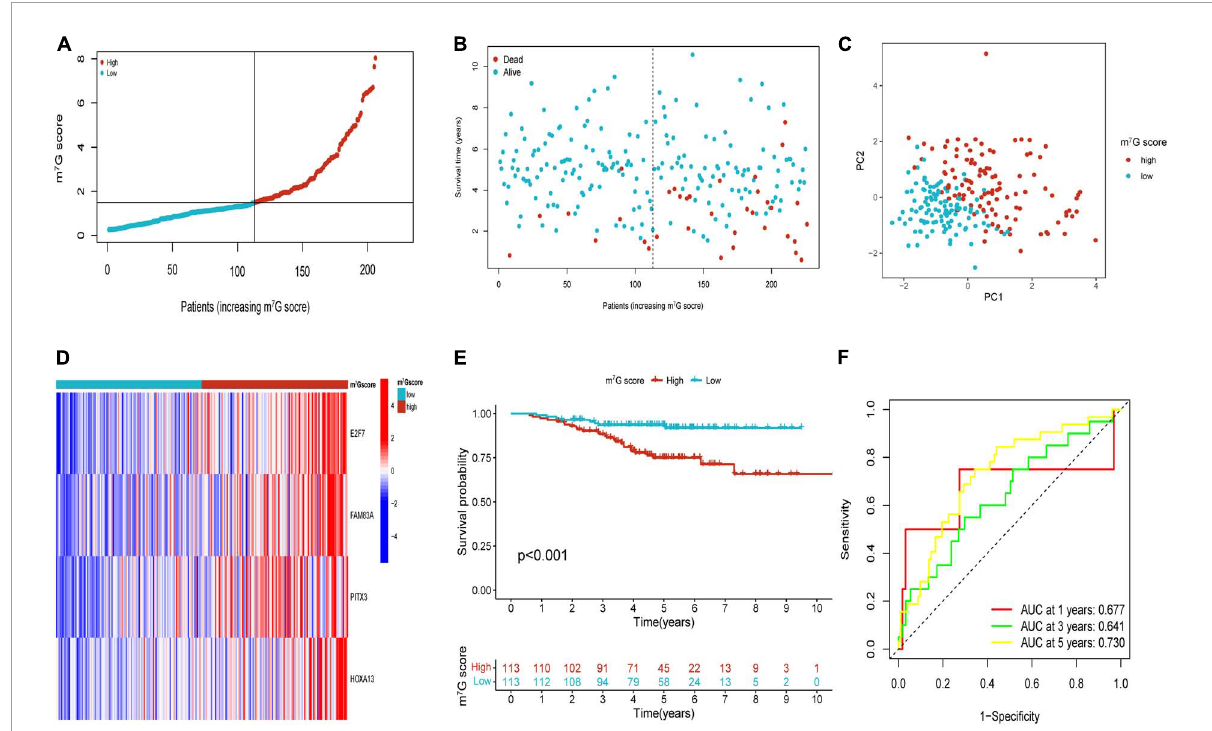
FIGURE7 Validation of m 7 G related signature in GSE31210. (A,B) The distribution of m 7 G score and survival state. (C) Distribution of patients according to m 7 G-related signature. (D) Heatmap of four genes expression between two groups. (E) Survival analysis between two groups. (F) AUC for predicting 1-, 3-, 5-years survival